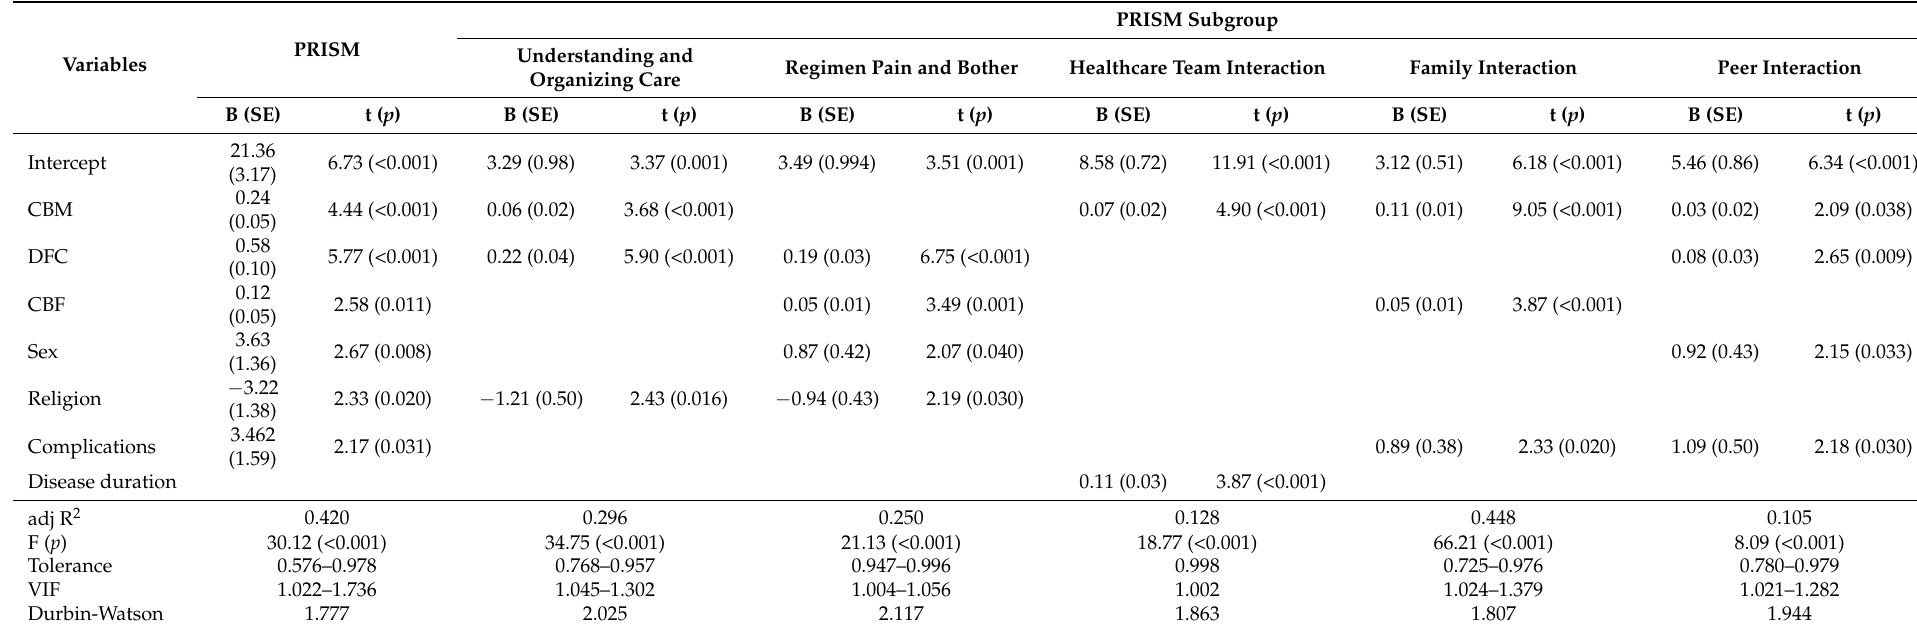
Table 5. Influencing factors on PRISM ( n =